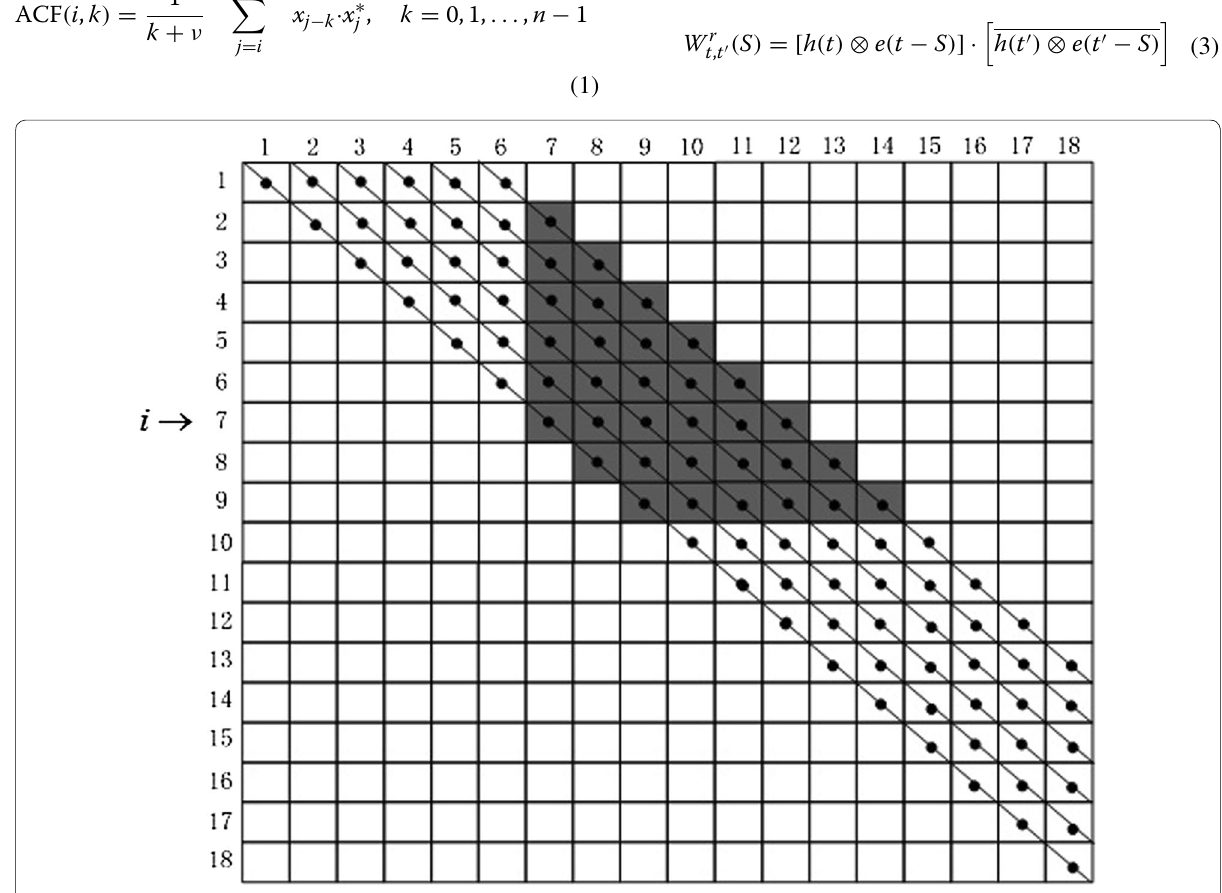
Fig. 8 Schematic diagram of the lag profile